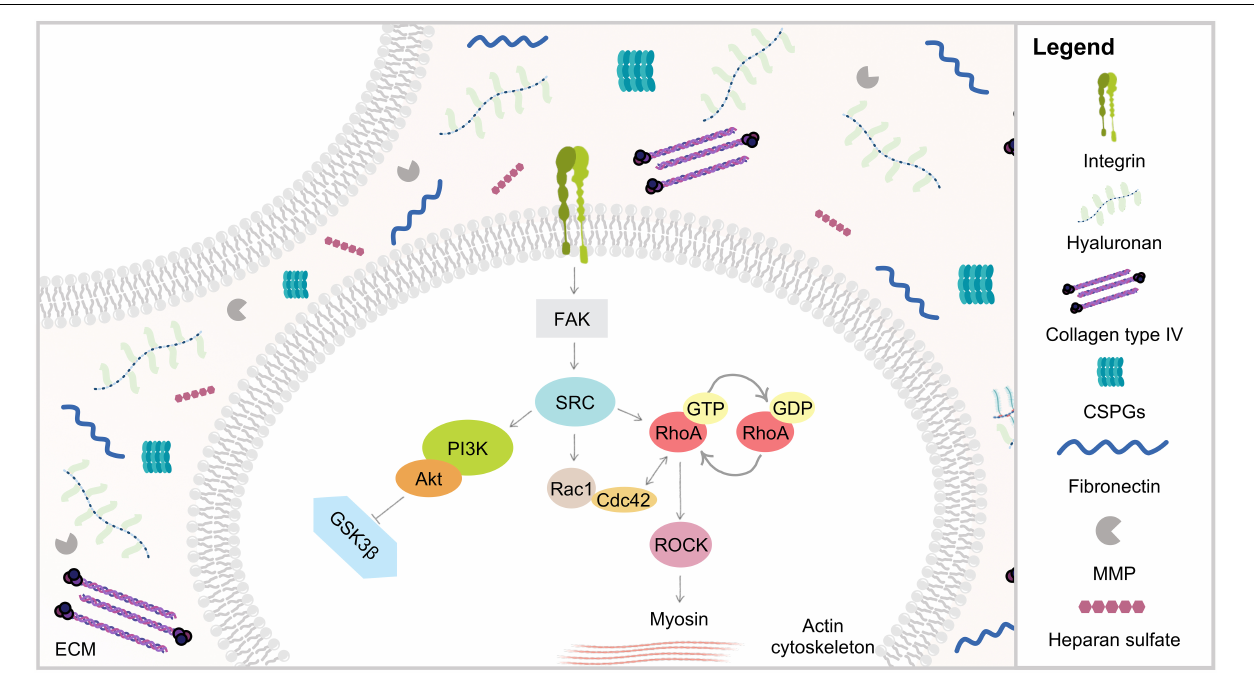
FIGURE 4 | Schematic representation of ECM biophysical dynamics via integrins. Mechanical stimuli are mediated through ECM proteins binding to transmembrane integrin receptors, triggering several signaling cascades such as PI3K and Rho/ROCK. RhoA plays an important role in actin stress fibers assembly through its major downstream effector ROCK, known to promote myosin light chain phosphorylation and increasing cell contractility.